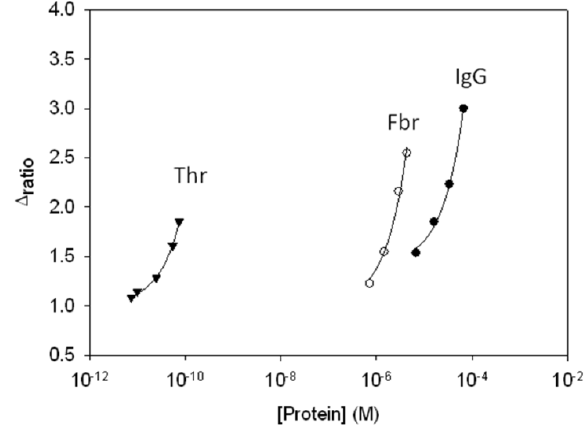
Figure 8. Response to proteins evaluated: IgG (●), Fbr (○) and Thr (▼).